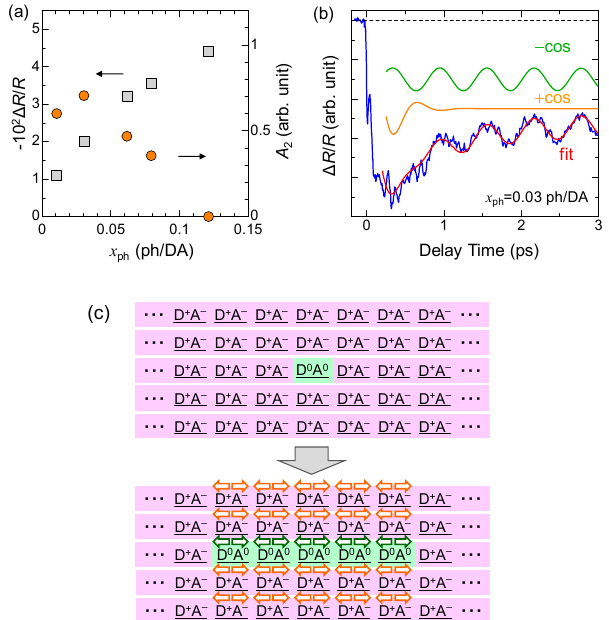
Figure 19. Analyses of the results of optical-pump optical-reflectivity-probe spectroscopy with the time resolution of ~20 fs in the I phase of TTF-CA. ( a ) Excitation photon density ( x ph ) dependence of reflectivity changes Δ R / R at around 2.2 eV (squares) and initial amplitudes of +cosine-type oscillations (circles) shown by the orange line in (b); ( b ) Normalized time evolutions of Δ R / R (the blue line). The red line shows a fitting curve. Two components of the fitting curve are shown by green and orange lines; ( c ) Schematic illustrations of coherent oscillations. − cosine-type oscillation and + cosine-type oscillation are generated in a neutral domain and in a surrounding ionic region, respectively.